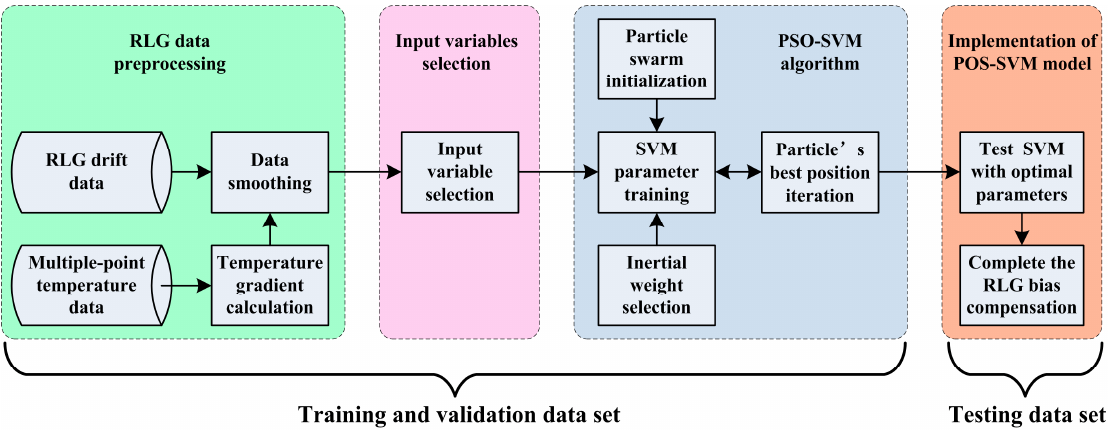
Figure 3. Flowchart of PSO-SVM model in RLG bias compensation.